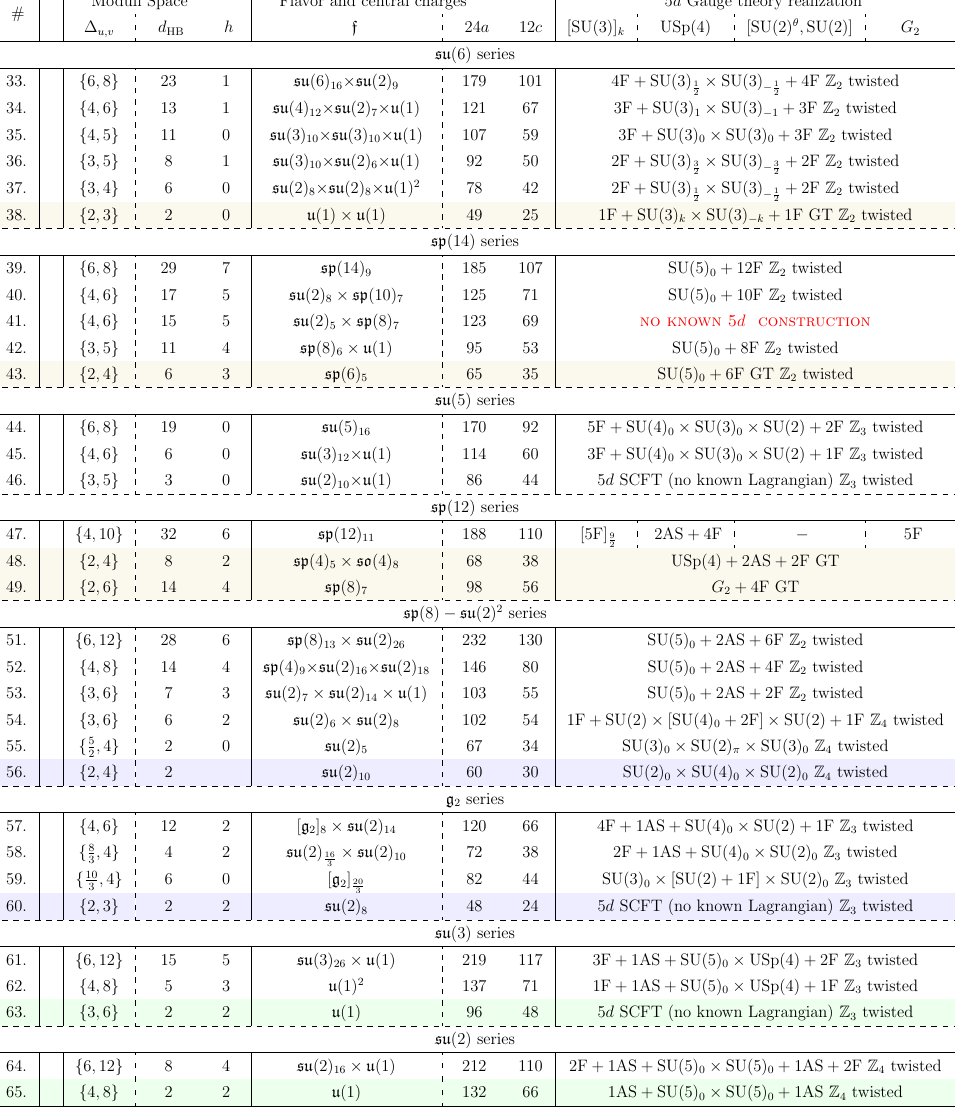
Table 2 . Continuation of rank-2 4 d theories with their corresponding CFT data and 5 d